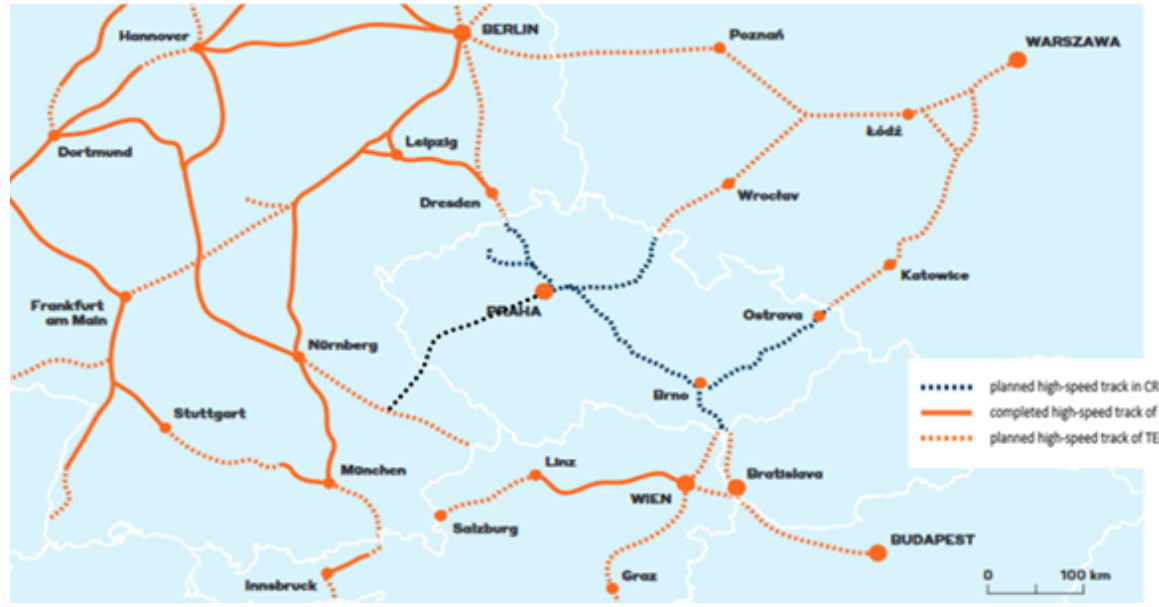
Figure 1. A Trans-European rail lines TEN-T [1].